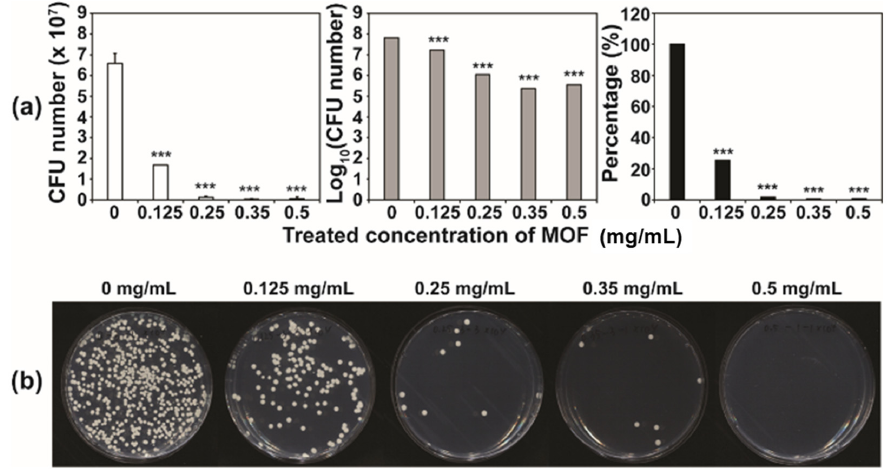
Figure 3. Antifungal activities of Cu(AZPY)-MOF against C. albicans . ( a ) Yeast cell viability indi- cated as the CFU number, Log 10 (CFU number), and relative percentage after 1 day of treatment with Cu-MOF . Each value in CFU number was an average of nine replicate measurements. Log 10 (CFU number) and relative percentage were calculated using the average value of CFU number. *** p < 0.001. ( b ) Pictures of plates showing CFU. The cell suspension was diluted 10 4 times after treatment with Cu(AZPY)-MOF and 100 μ L was spread onto the plates.